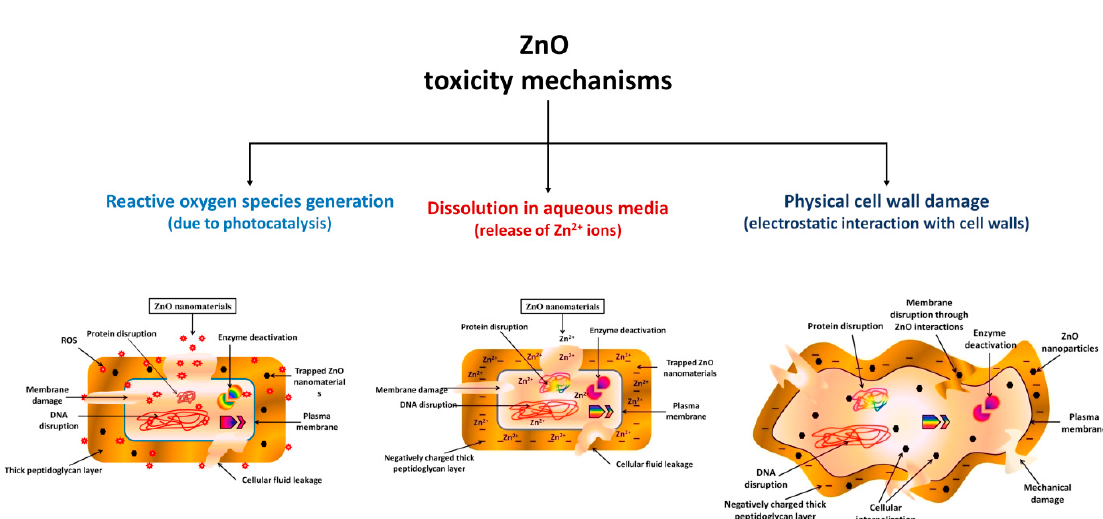
Figure 9. Schematic reporting the main ZnO toxicity mechanisms that make this material an effective antimicrobial agent. Adapted from ref. [232] .